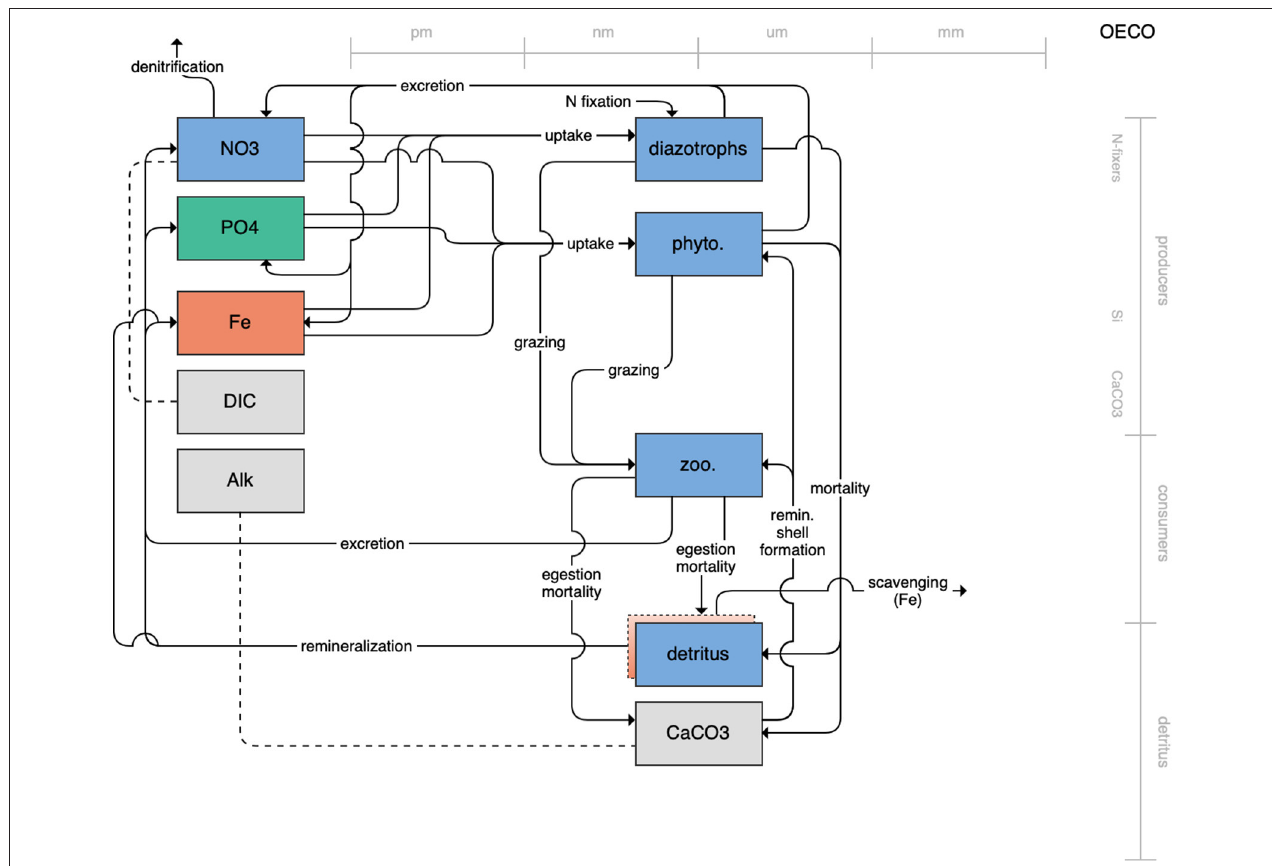
FIGURE 6 | Schematic for the OECO model. See Figure 1 caption for